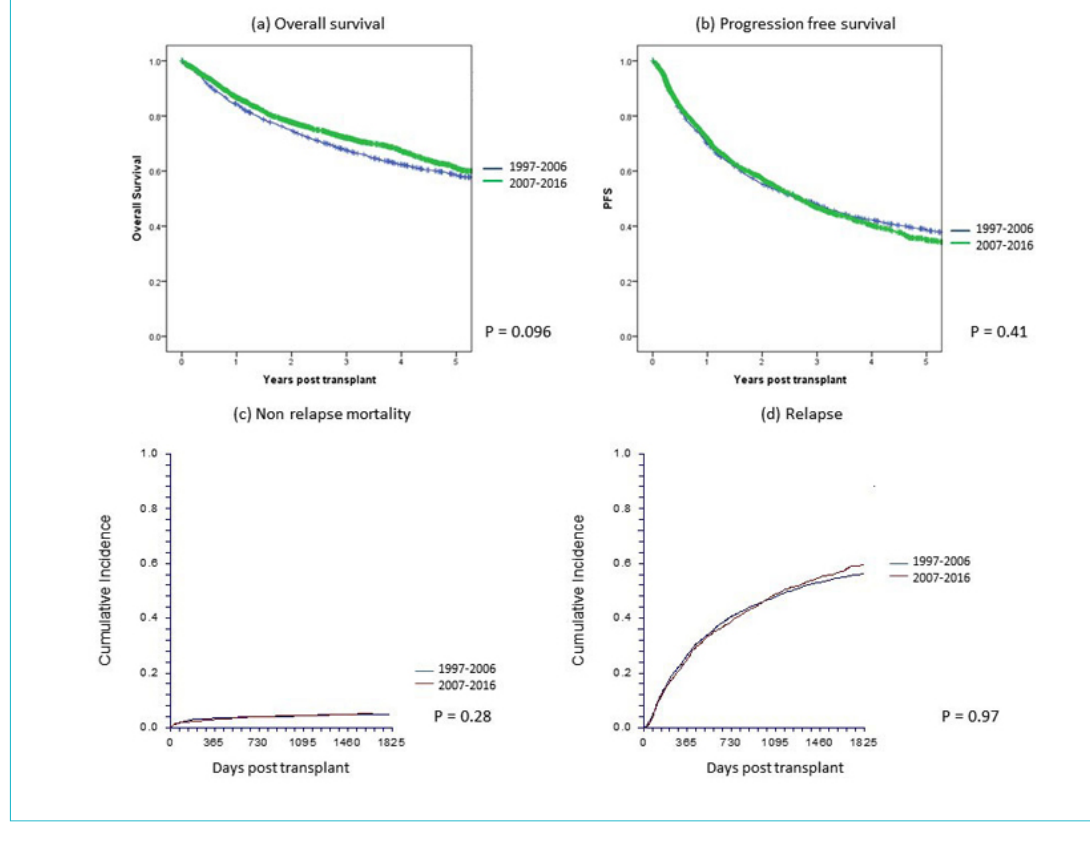
Figure 2: Main outcome of 5118 patients with autologous haematopoietic cell transplants by year group in Switzerland between 1997 and 2016: (a) overall survival, (b) progression-free survival, (c) nonrelapse mortality and (d) relapse.